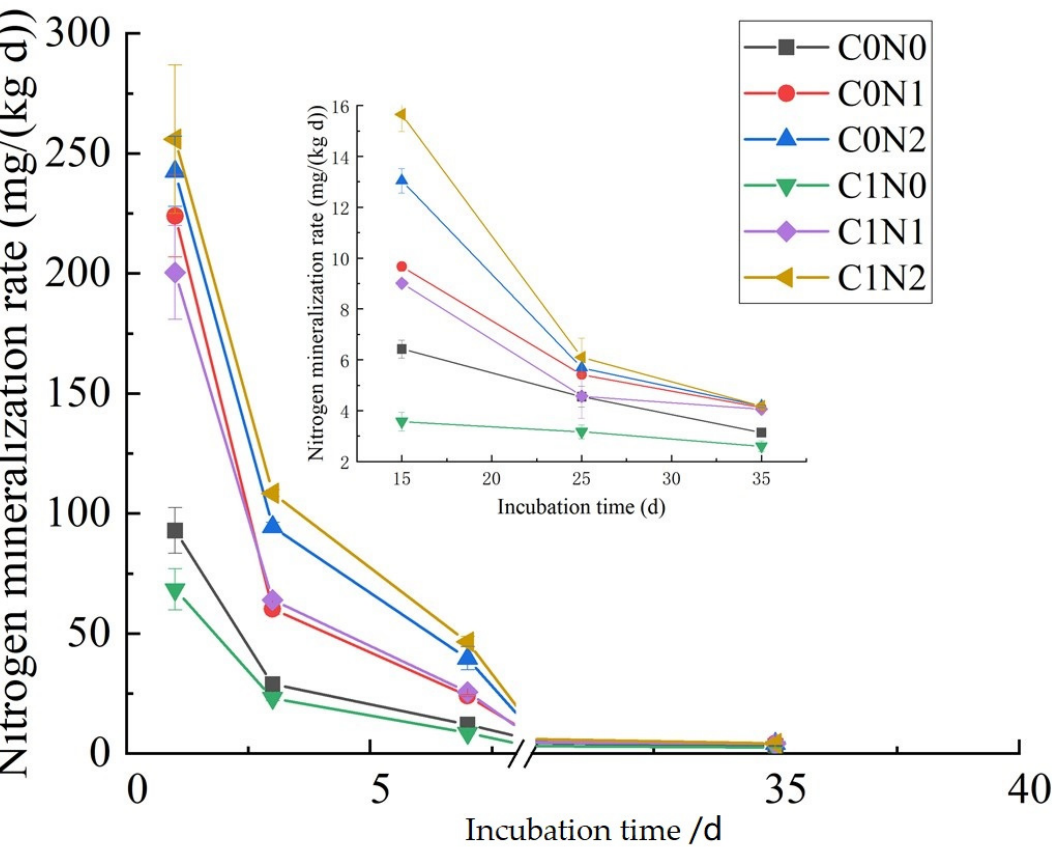
Figure 1. Dynamic changes in the nitrogen mineralization rate in saline soil during cultivation. Table 3. ANOVA of the nitrogen mineralization rate of saline soil with the return of straw and the application of